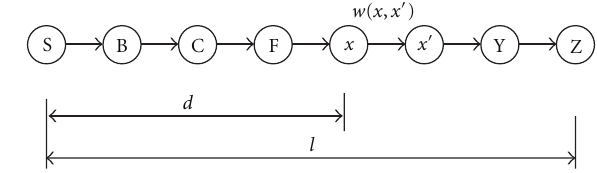
Figure 3: The example for consistent property of A ∗